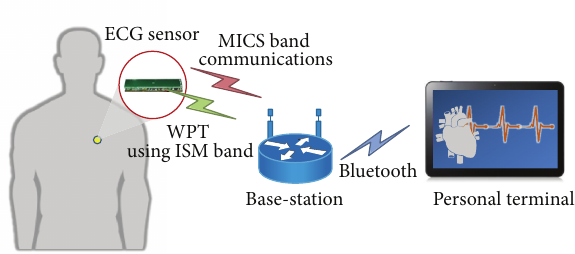
Figure 1: The concept developing the ECG monitoring system.